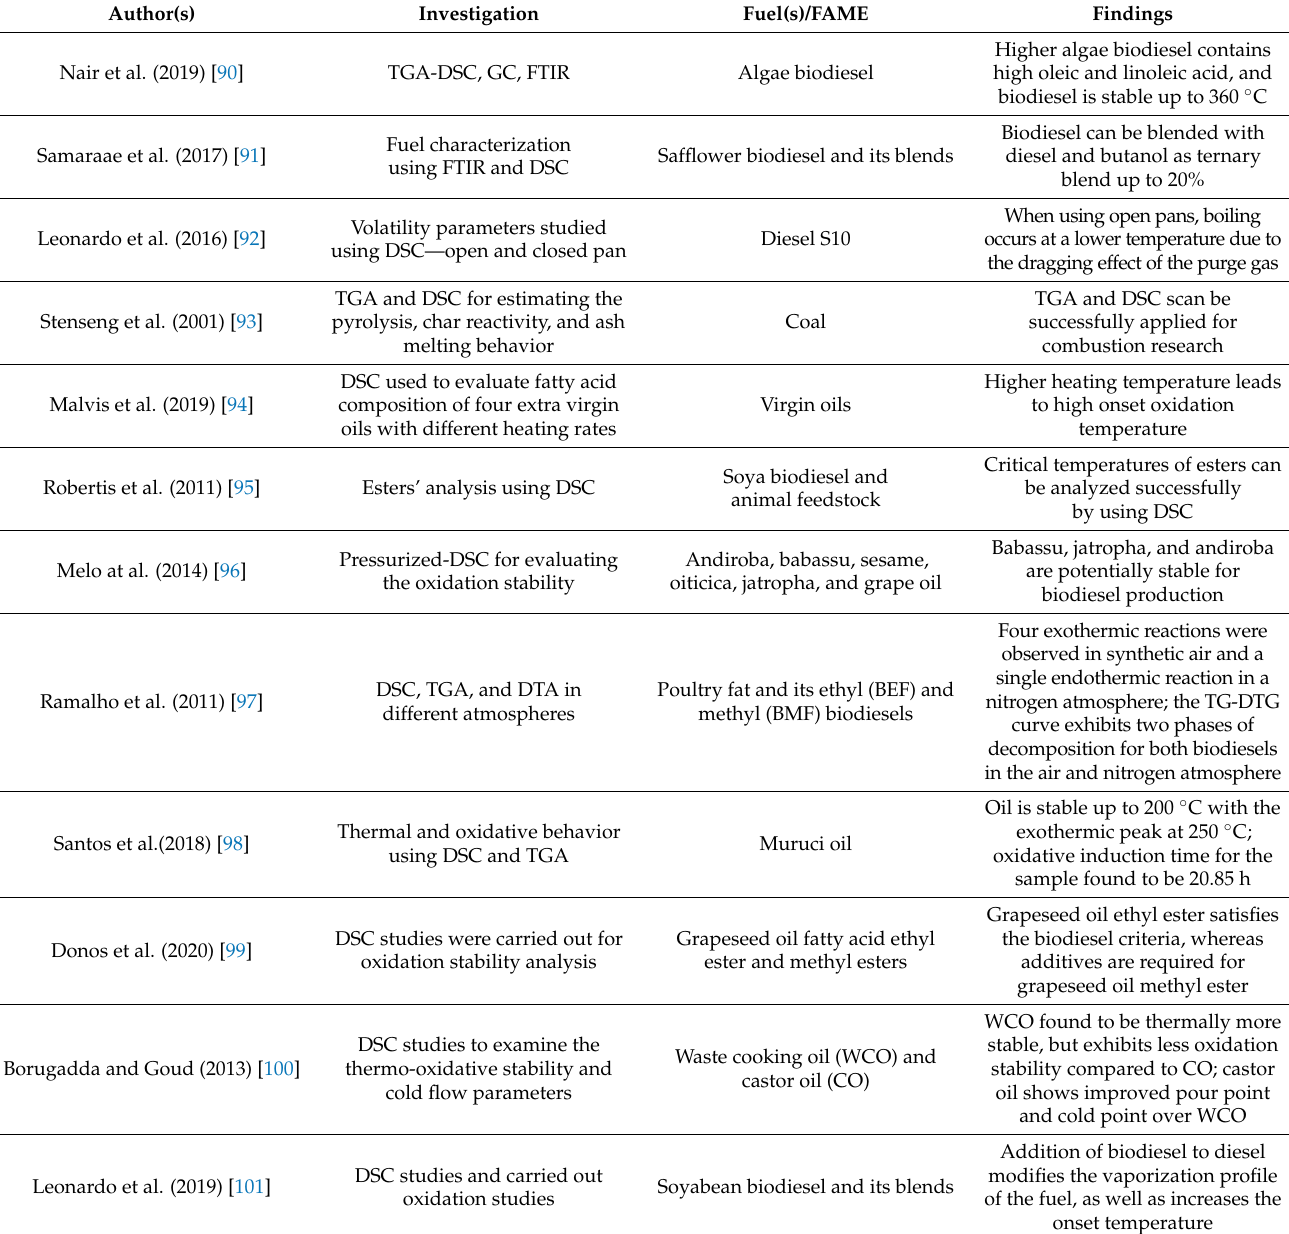
Table 2. A summary of articles related to DSC